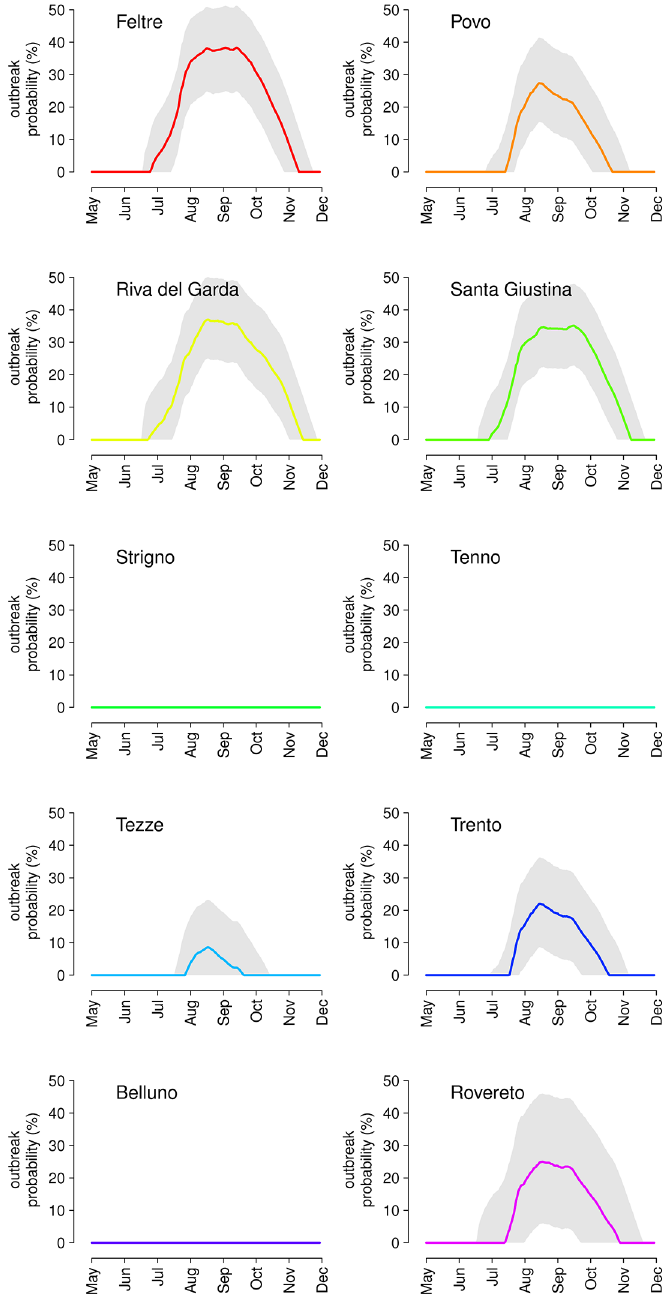
Fig 6. Model predictions for the probability of occurrence (average and 95% CI) of an outbreak of sustained chikungunya transmission caused by a single importation of an infected case occurred at different times of the year in the ten study